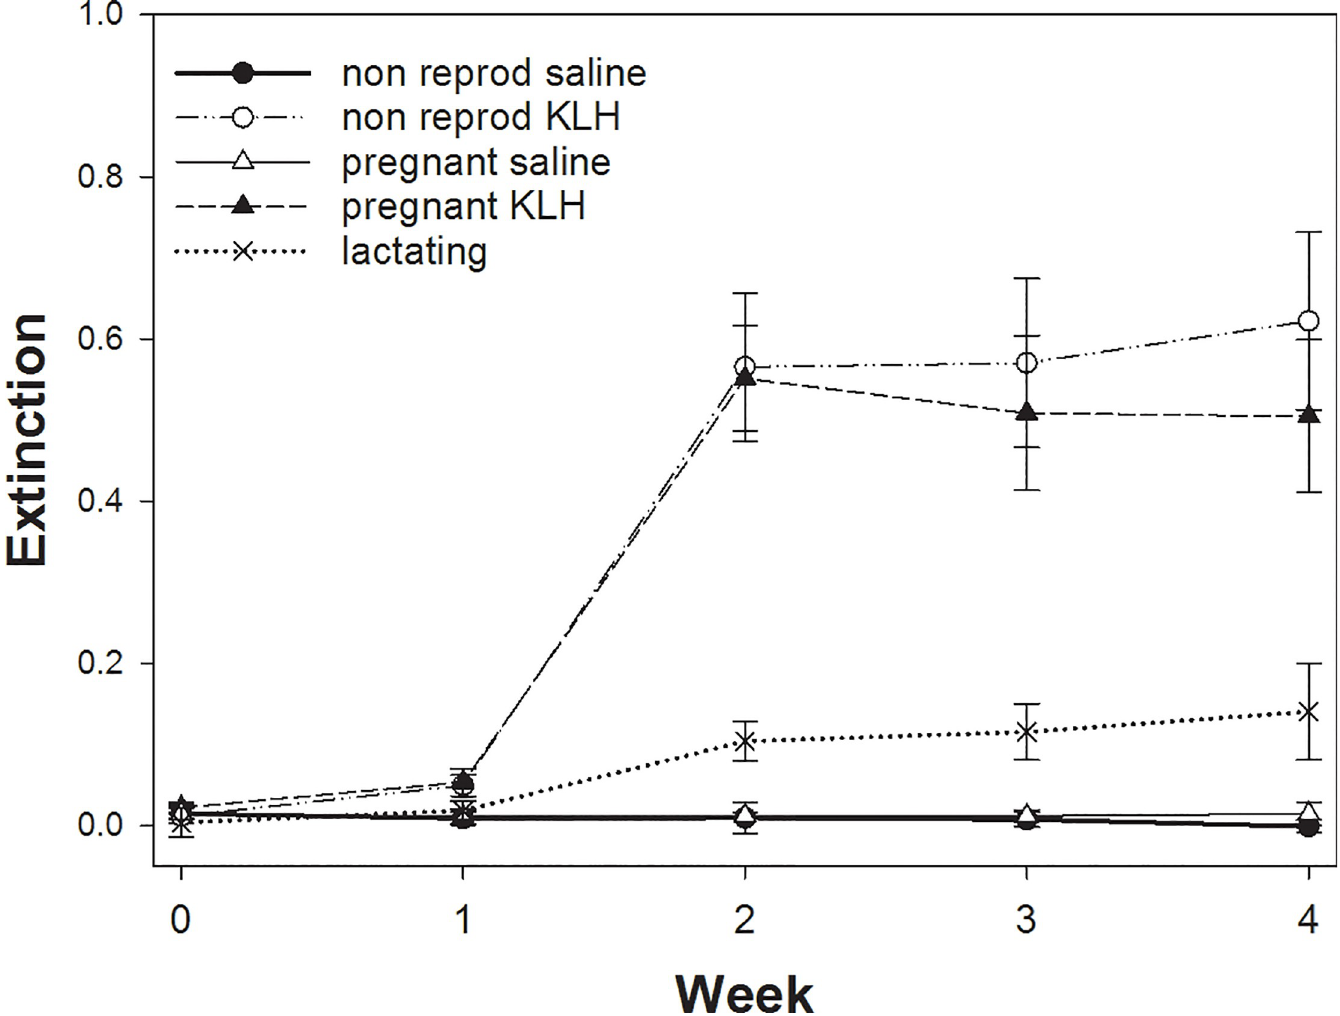
Fig 1. Differences in the adaptive immune response across the 4 weeks as measured by KLH-Elisa by females in Experiment I. Plotted are means and SE. For details see